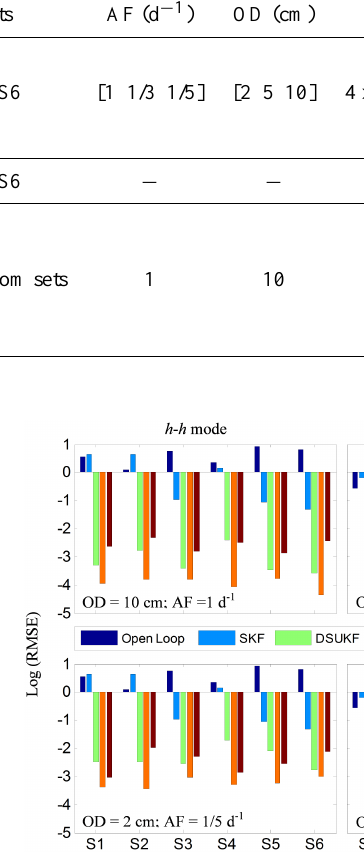
Table 2. Summary of numerical experiments involved in the performance analyses. Algorithms